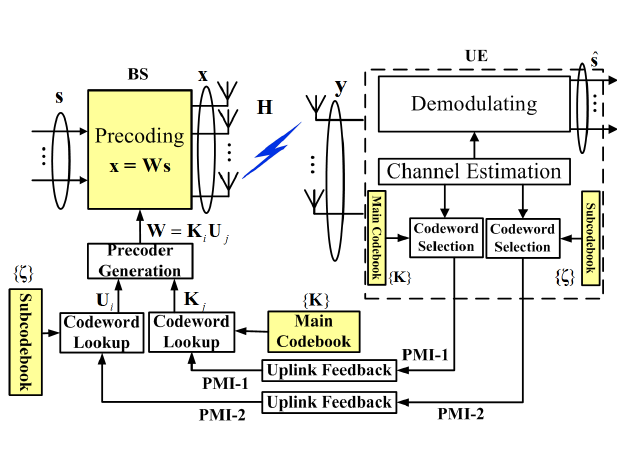
Figure 1. The Limited Feedback Precoding Model } as the first part and the subcode- K = { K 1 , K 2 , · · · , K N book ζ = { U 1 , U 2 , · · · , U G } as the second part. Assum- ing that the feedback overhead is limited to B bits, the size of these two parts should satisfy N × G = 2 B